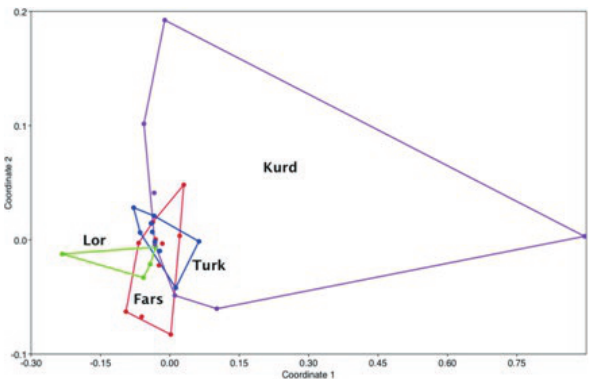
Figure 2. MDS plot of the studied sequences based on ethnic group samples showing admixture of the samples.